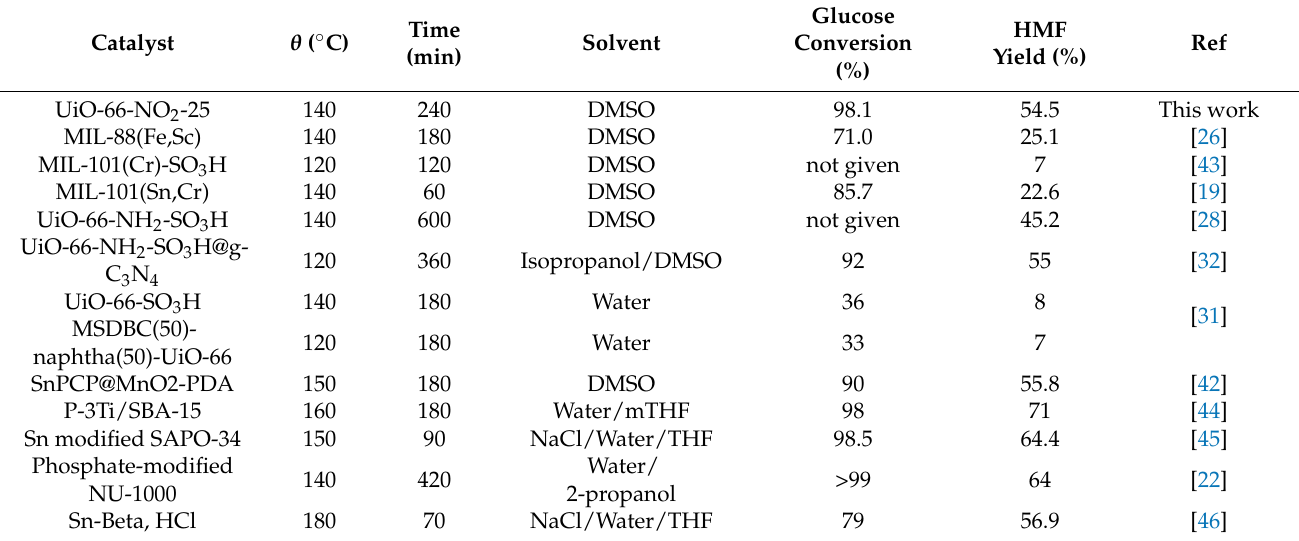
Table 5. Reported glucose conversion to HMF catalysed by heterogeneous